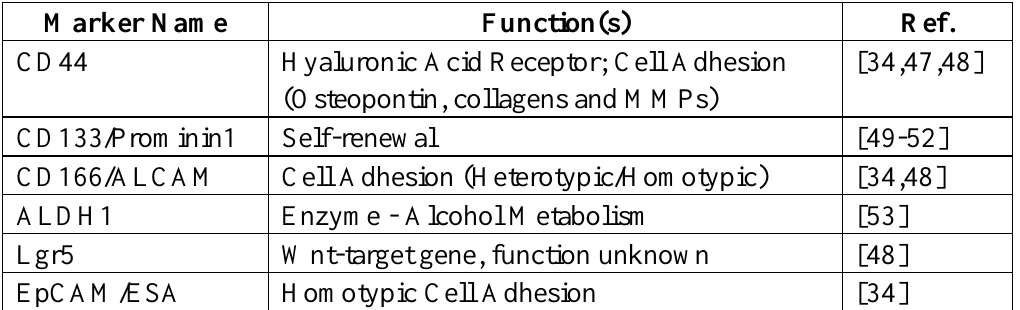
Table 1. Colorectal Cancer Stem Cell